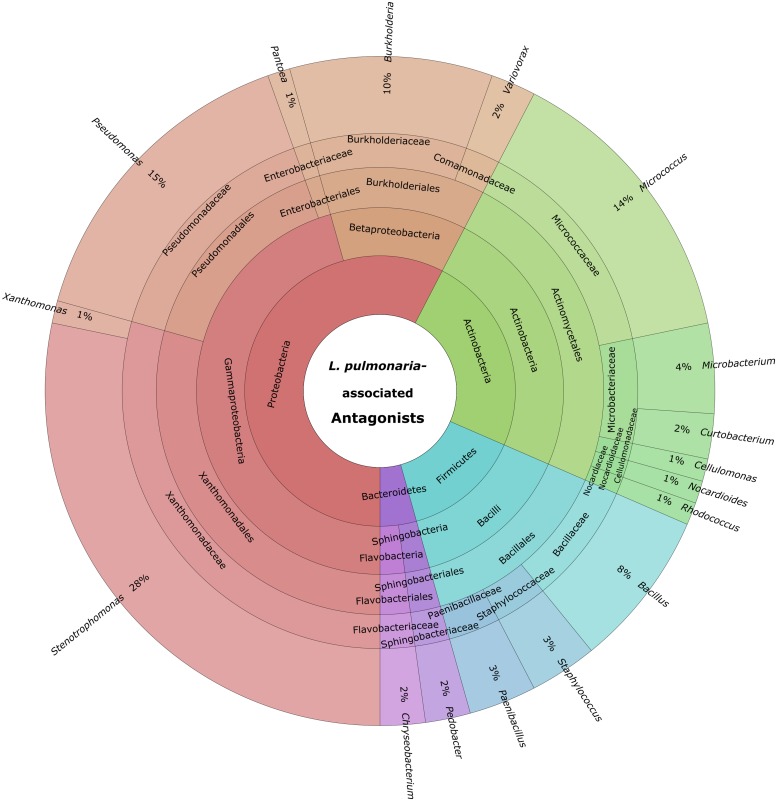
Summary of identified antagonistic bacteria in a multi-level chart (http://sourceforge.net/p/krona). The displayed taxa were shown to inhibit growth of one or more of the utilized model pathogens: B. cinerea, E. coli, S. aureus, and Rhinocladionella sp. The inner circles represent higher taxonomic ranks, while more detailed taxonomic ranks (up to genus level) are presented in the outer circles.